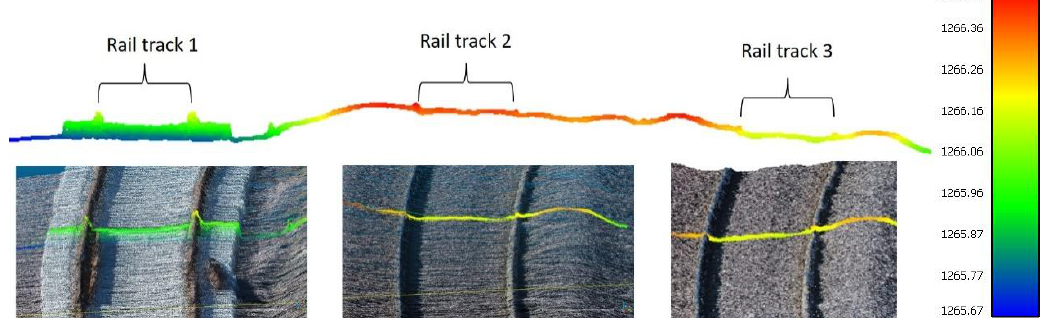
Figure 5. Cross section of railroad tracks that are colored according to the relative height of the points.